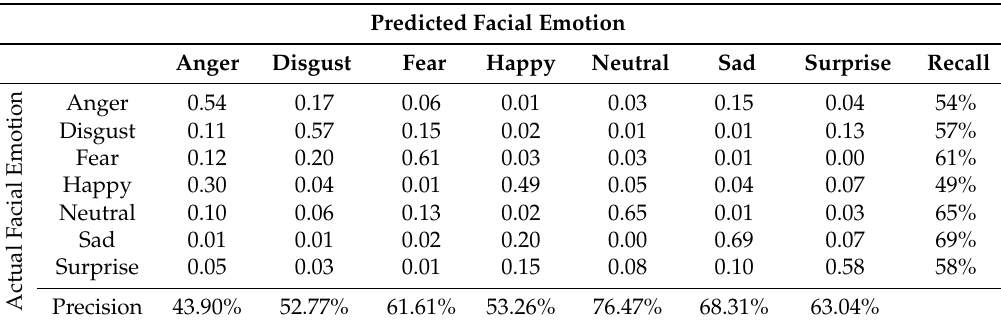
Table 2. Confusion matrix for the real-world affective faces (RAF) dataset. Predicted Facial Emotion